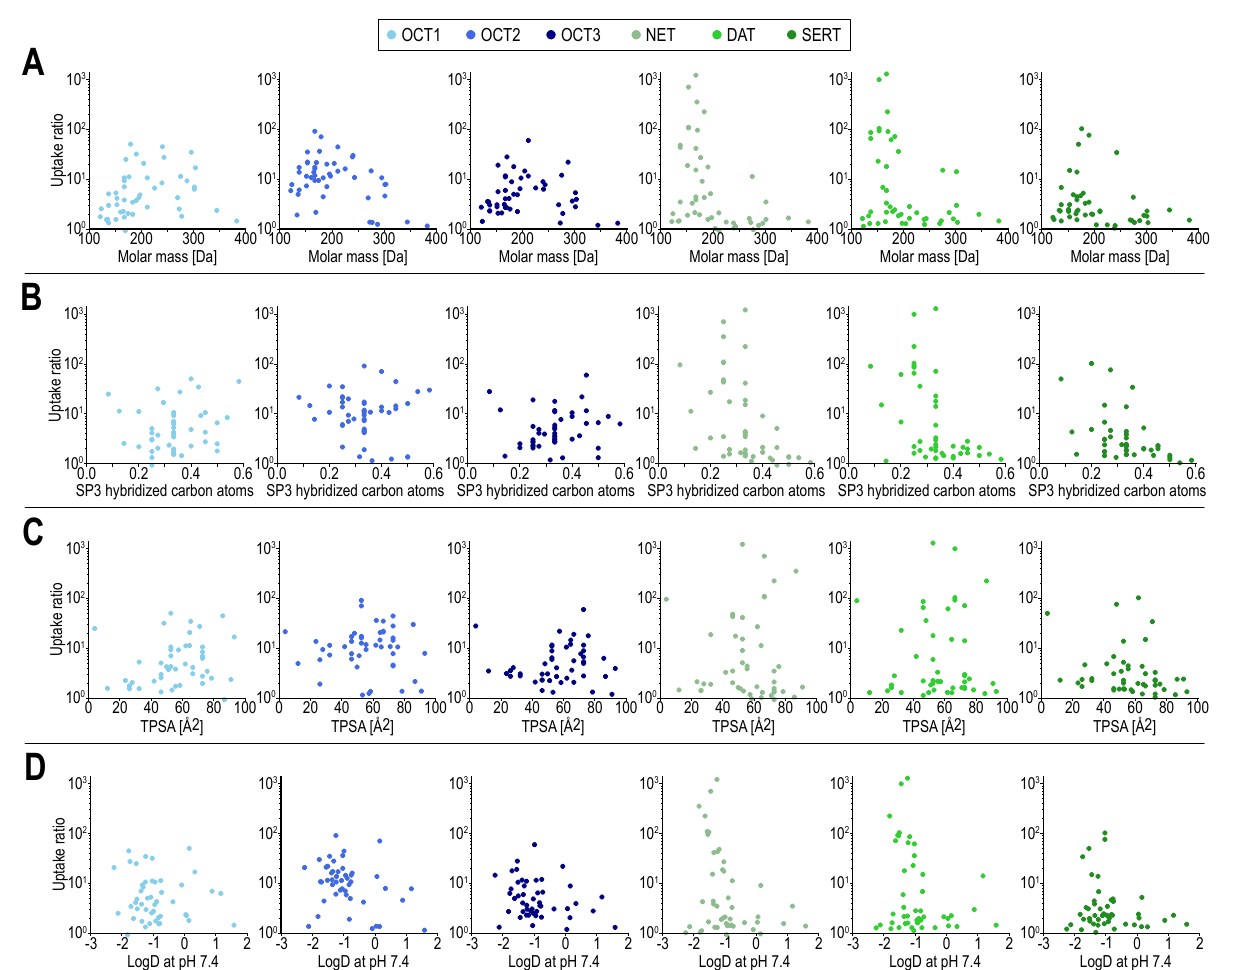
Figure 2. Transport ratios (uptake into overexpressing cells over uptake into empty-vector control cells) for all compounds on the ordinate. On the abscissae molar mass ( A ), fraction of SP3 hybridized atoms ( B ), total polar surface area (TPSA) in ( C ), and logD (at pH 7.4) in ( D ). Scatter colors indicate the respective transporters, with MATs in green and OCTs in blue. In ( B ) ethambutol, as an outlier, with a fraction of SP3 hybridized carbon atoms of 1 is not shown. LogD at pH 7.4 was calculated using the software cxcalc from ChemAxon, Budapest, Hungary, the remaining molecular descriptors were calculated using RDKit, RDKit: open-source cheminformatics software, https://www.rdkit.org/ (accessed on 7 October 2021).